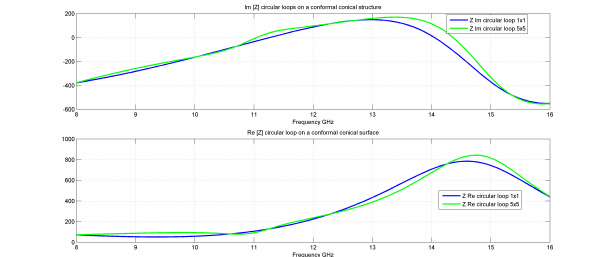
Fig. 9.Imaginary part (top panel), and real part (bottom panel) of Z A of the isolated loop wire (blue line) and the wire surrounded by identical passive ones (green line)